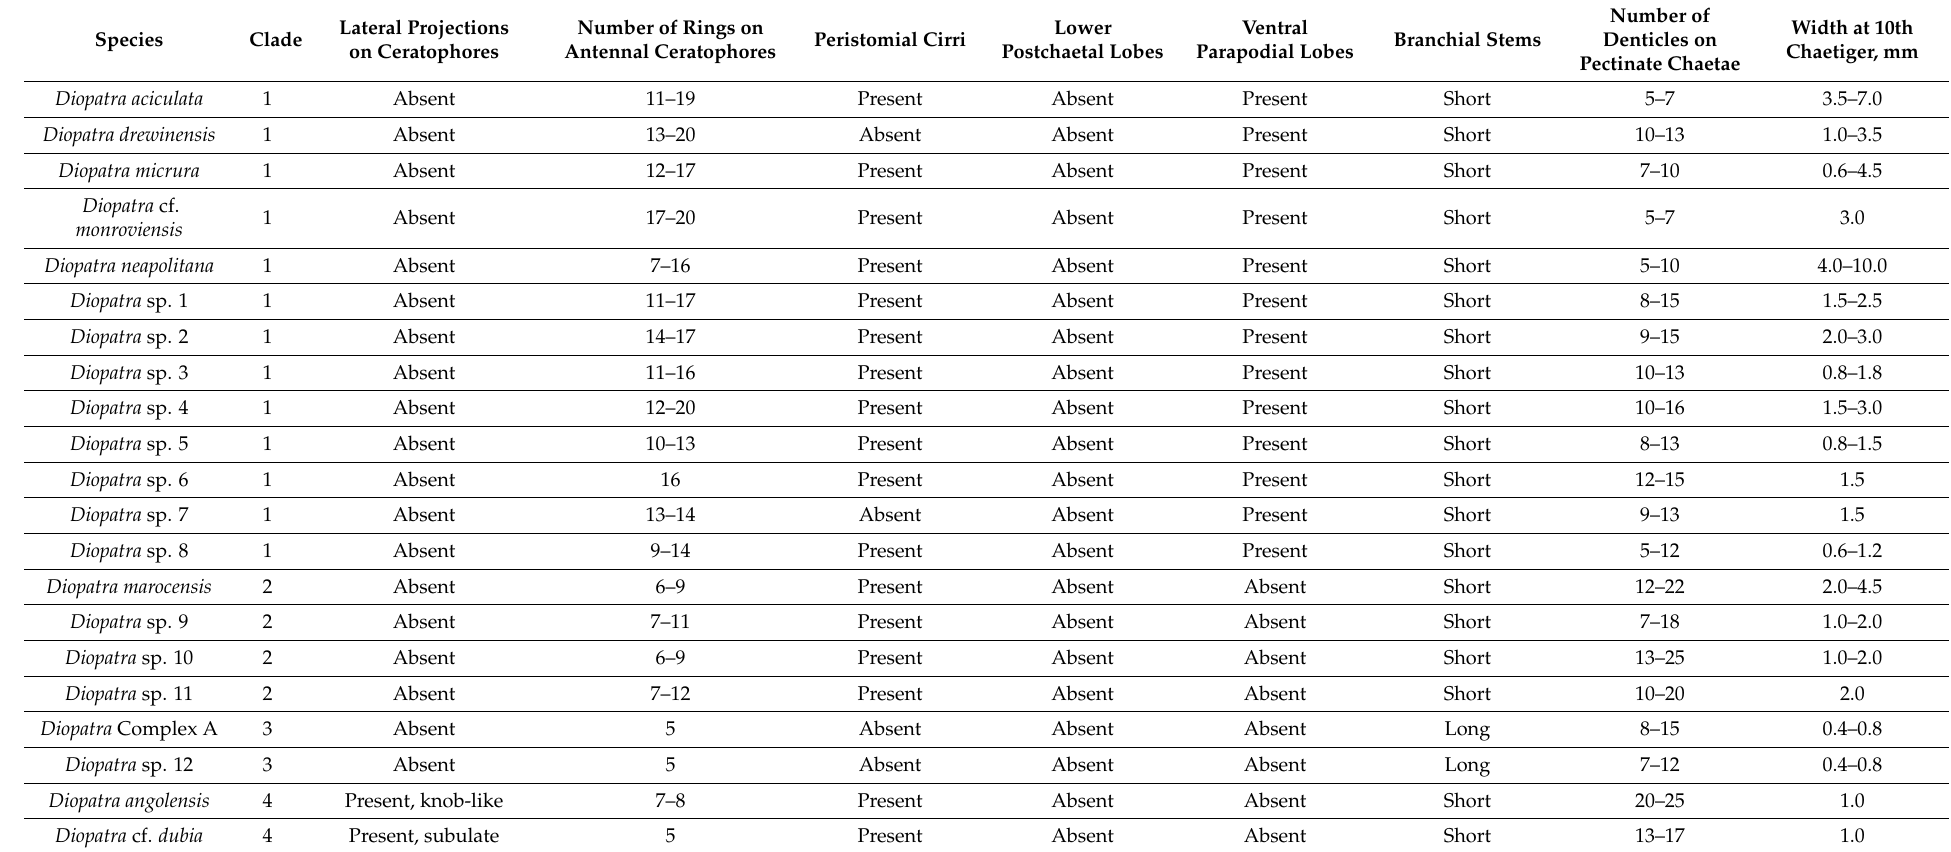
Table 1. Morphological matrix of eight morphological characters for all species in this study. References for morphological data are shown in Table